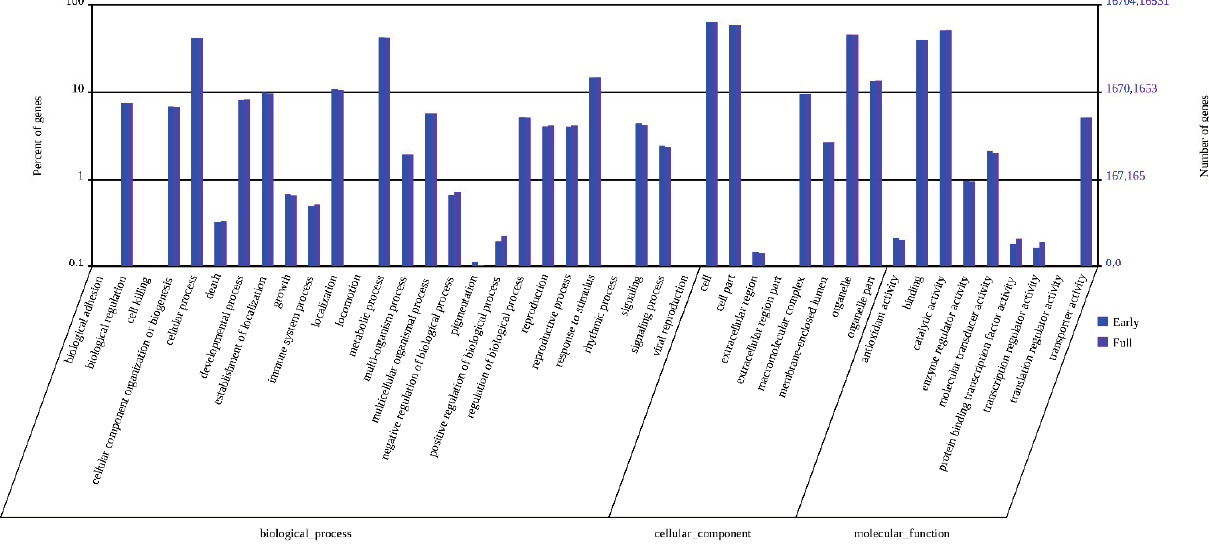
Figure 5. Gene ontology (GO) annotation of all safflower unigenes. There are 26 functional annotations in